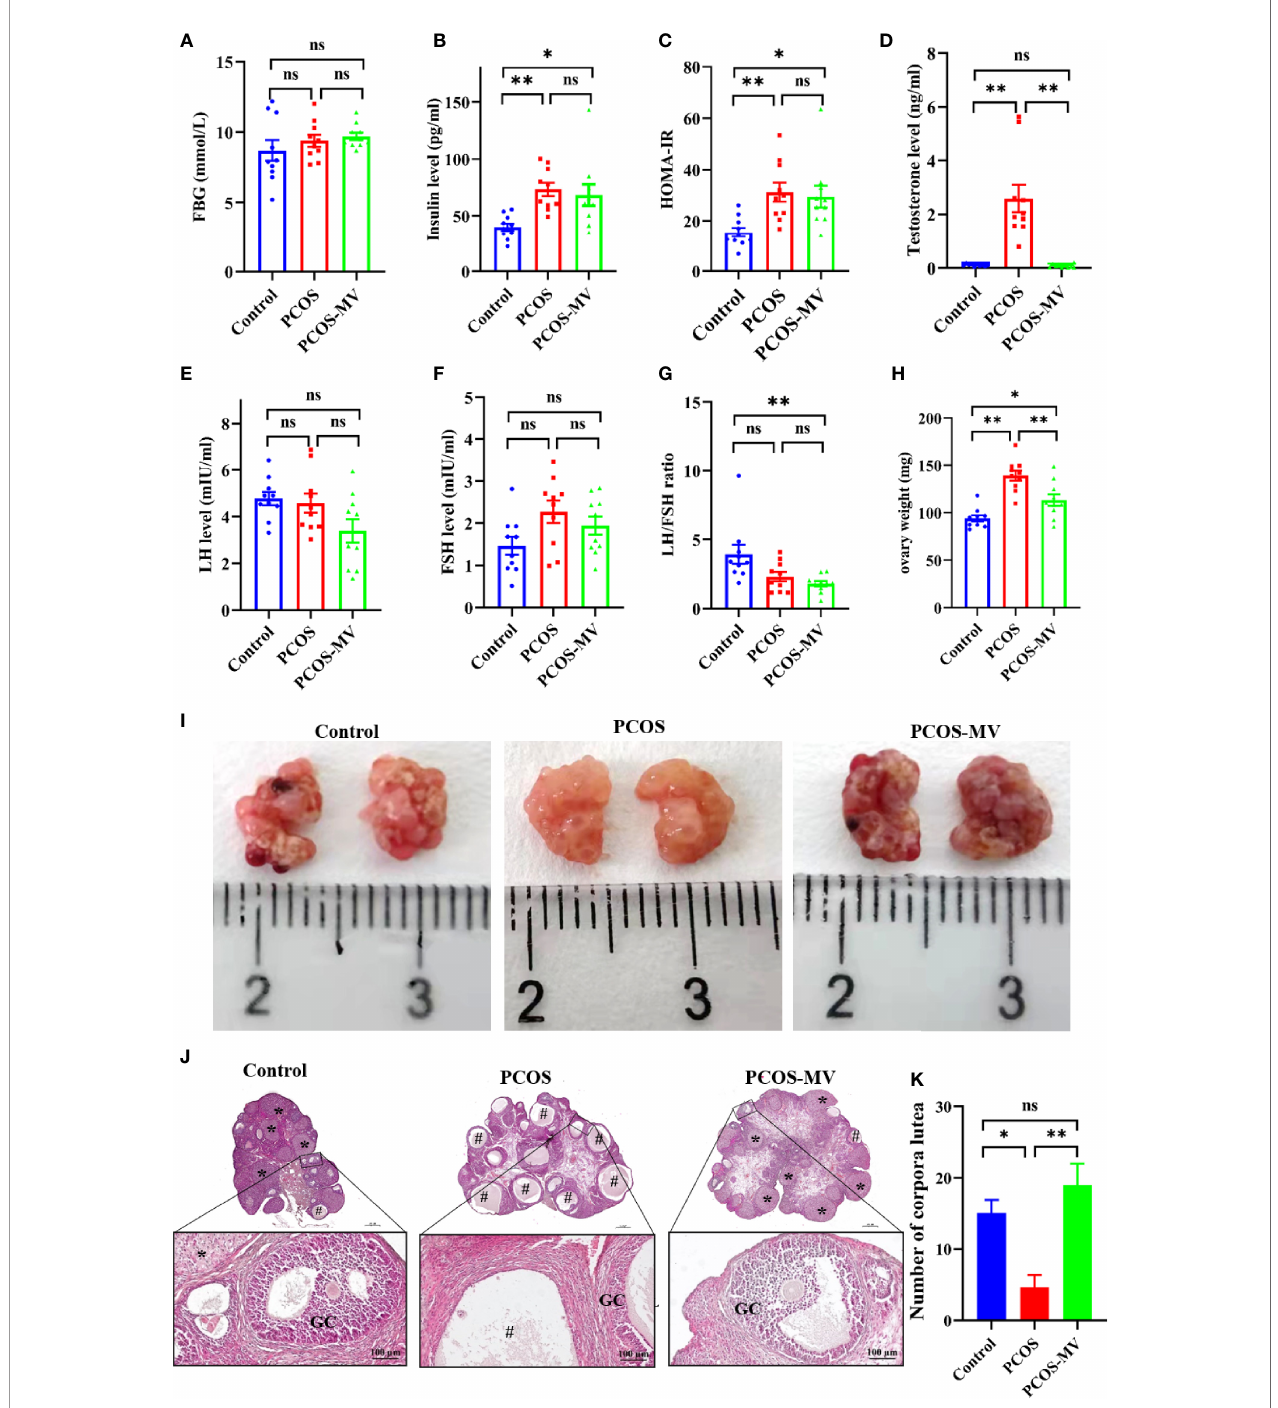
FIGURE 2 | Effects of MV administration on hormone level, ovary weight and ovary morphology. (A) FBG (n = 10 rats per group). (B) Insulin (n = 10). (C) HOMA-IR (n = 10). (D-F) Serum levels of sex hormone indicators including testosterone (T), luteinizing hormone (LH) and follicle-stimulating hormone (FSH) (n = 10). (G) LH/ FSH ratio. (H) Effects of MV treatment on the ovary weight of PCOS rats (n = 10). (I) Appearance of representative ovaries. Dark red regions show the corpora lutea. (J) Histological structure of ovarian tissues (n = 6 rats per group, scale bar in upper is 500 m m). The lower panel show the higher magni fi cation of the box area in the upper panel respectively. (K) Quanti fi cation of the number of corpora lutea (n = 6). “ # ” indicated the cystic follicles, “ * ” indicated the corpus luteum. Signi fi cant differences between groups were indicated as * P < 0.05, ** P < 0.01. GC, granulosa cell. ns, no signi fi